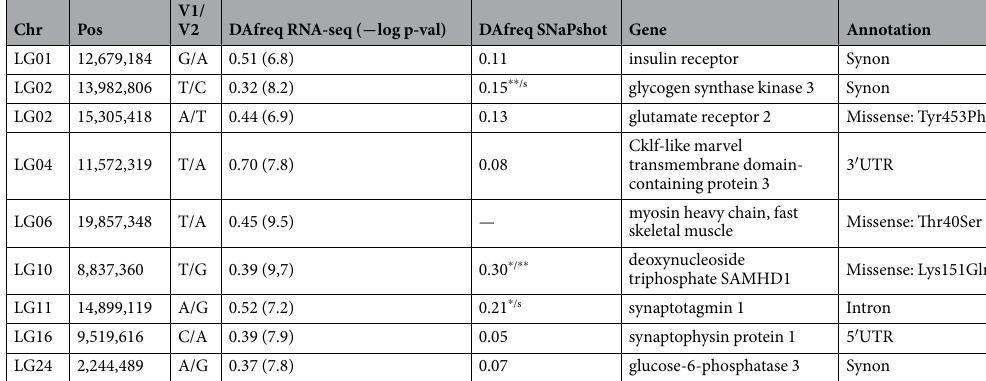
Table 3. Selection of SNPs showing divergent allelic frequencies between high and low growth turbot. For each SNP the chromosome (Chr), the position in the chromosome (Pos), the major variant (V1), the minor variant (V2), the allelic frequency difference (DAfreq) and Fisher’s test − log10 p-value ( − log pval) obtained from the RNA-seq, the DAfreq and significance of genotypic/allelic divergence (G-tests; s: p < 0.10, * p < 0.05, ** p < 0.01) obtained from SNaPshot, the gene the SNP belongs to (Gene) and the SNP annotation regarding the gene (Annotation; Synon: synonimous) are